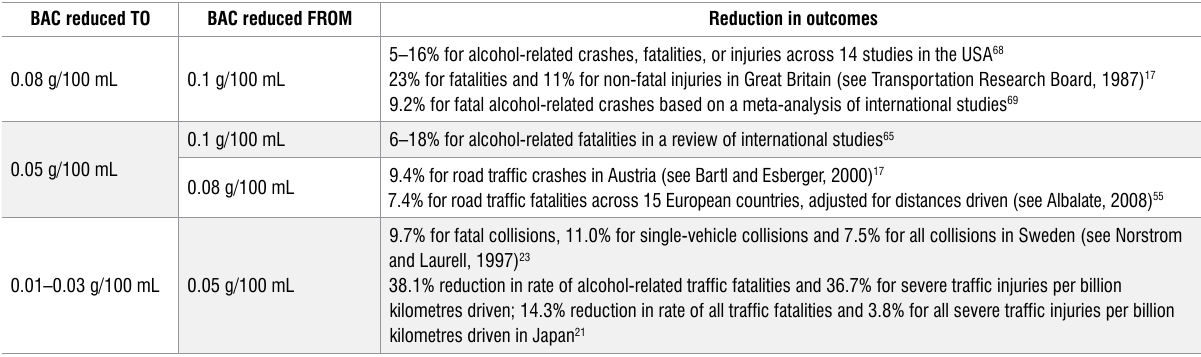
Reductions in road traffic mortality and other adverse outcomes following reduced blood alcohol concentration (BAC) threshold limits BAC reduced TO BAC reduced FROM Reduction in